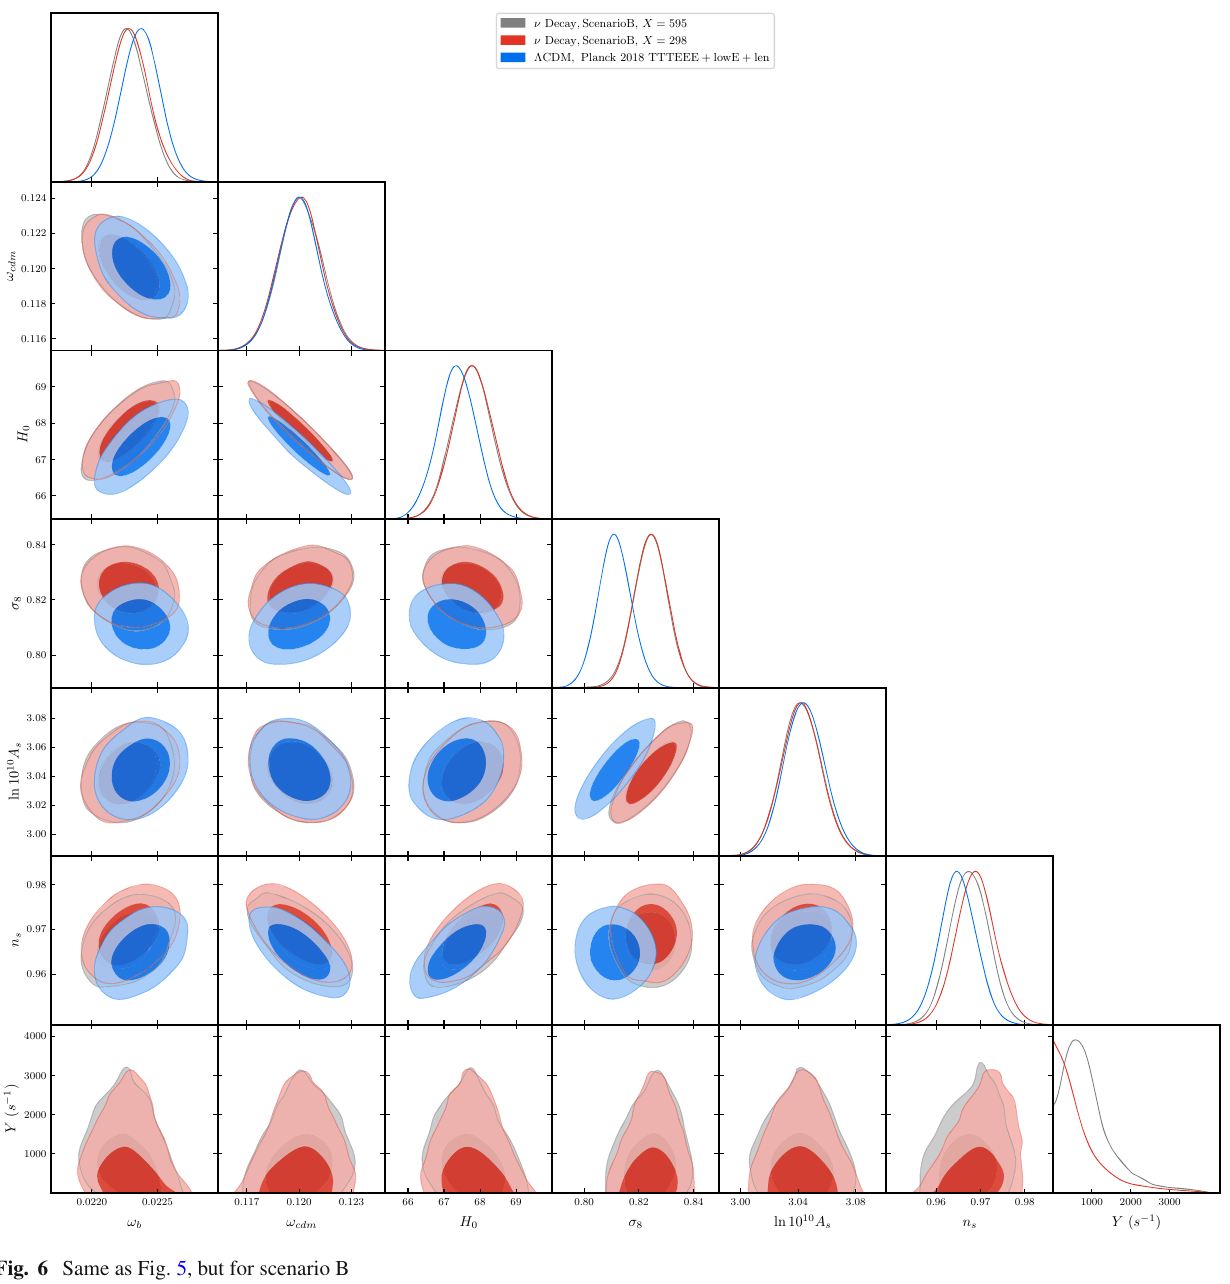
Fig. 6 Same as Fig. 5, but for scenario